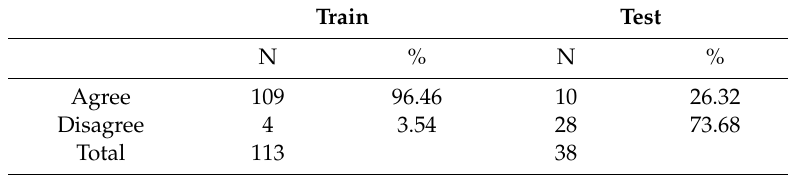
Table 5. Agreement between the models developed to classify the soil characteristics.